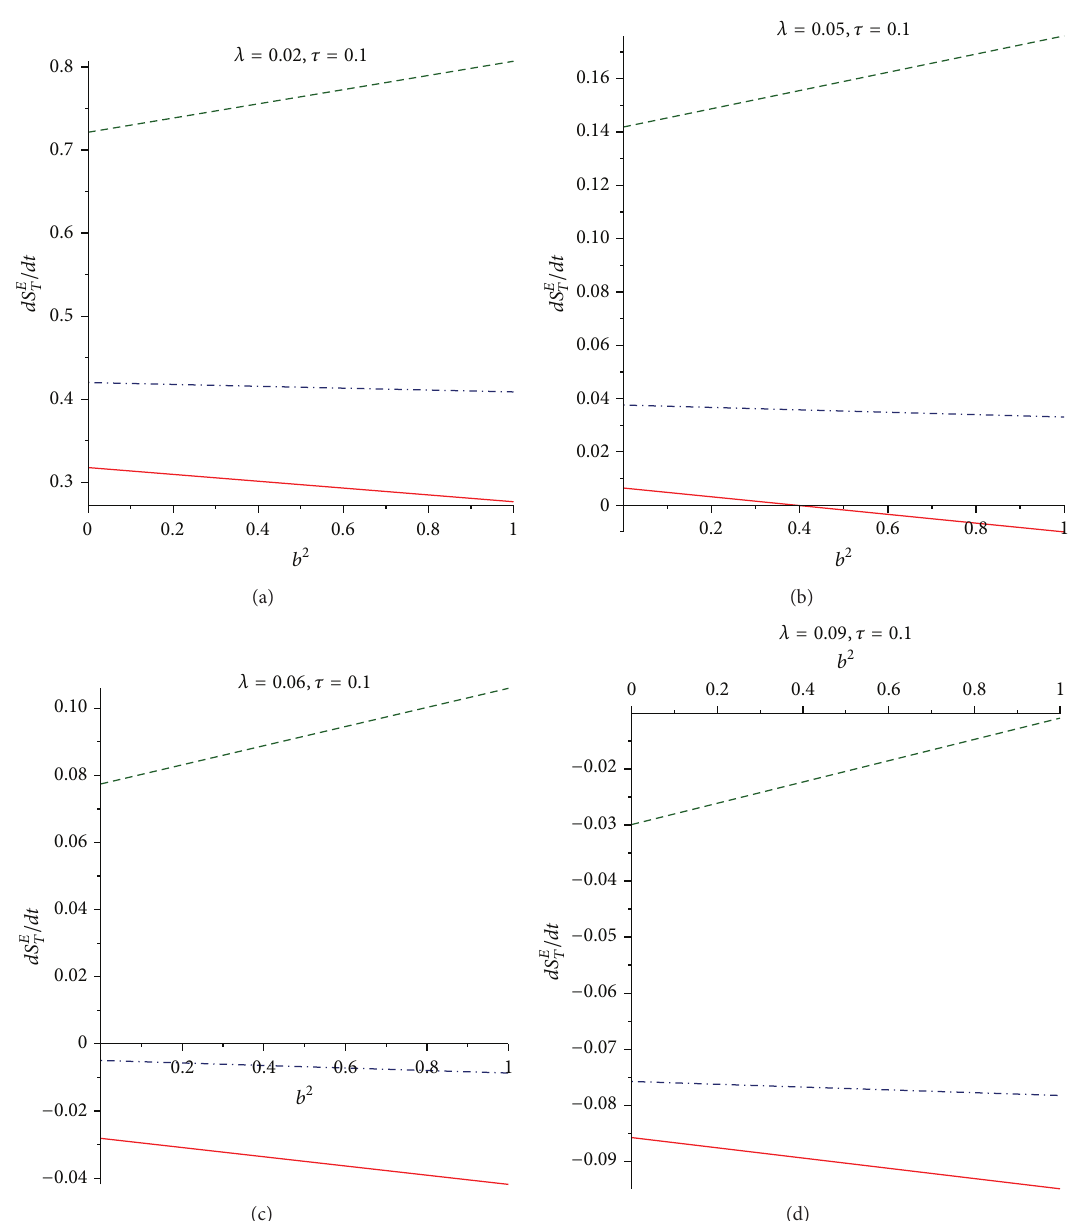
Figure 2: The above 4 plots show the variation of 𝑑𝑆 𝐸 𝑇 /𝑑𝑡 against the coupling parameter 𝑏 2 for different values of 𝜆 and for 𝜏 = 0.1 . The red (solid), green (dash), and blue (dash-dot) curves correspond to data sets 1, 2, and 3,